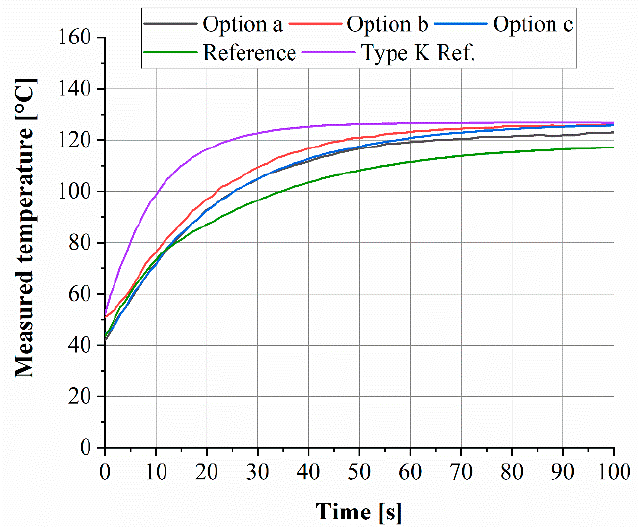
Figure 11. Step function response of the Ni/Ni-20Cr thin film coated with different AlN-1 layer options and step function response of the reference thermocouple.